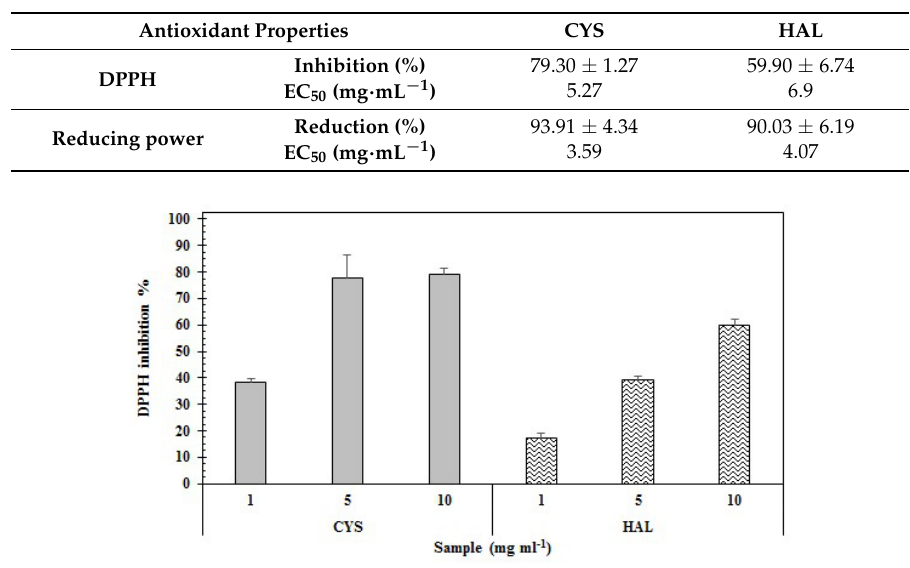
Figure 2. Percentage of inhibition of the radical DPPH in presence of different concentrations of aqueous extracts of CYS and HAL.